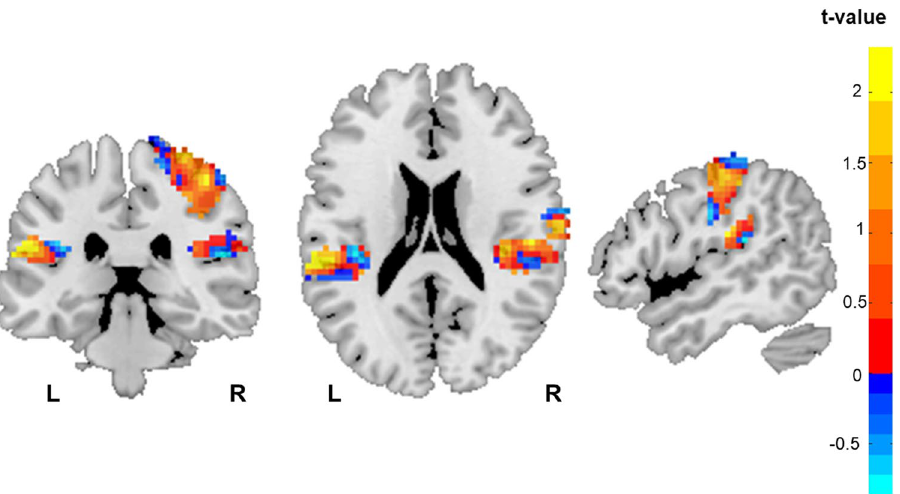
Figure 5. Voxelwise t-maps for the stimulus × load interaction in somatosensory areas (contralateral SI, contra-, and ipsilateral SII) for exploratory reasons. In this figure, the untresholded t-values per voxel for the contrast (low load (stimulus–no stimulus)—high load (stimulus–no stimulus)) are shown. While descriptively increased t-values are seen, please note that the permutation analysis did not reveal significant effects and that Bayes factors for the averaged activity in somatosensory areas support the null